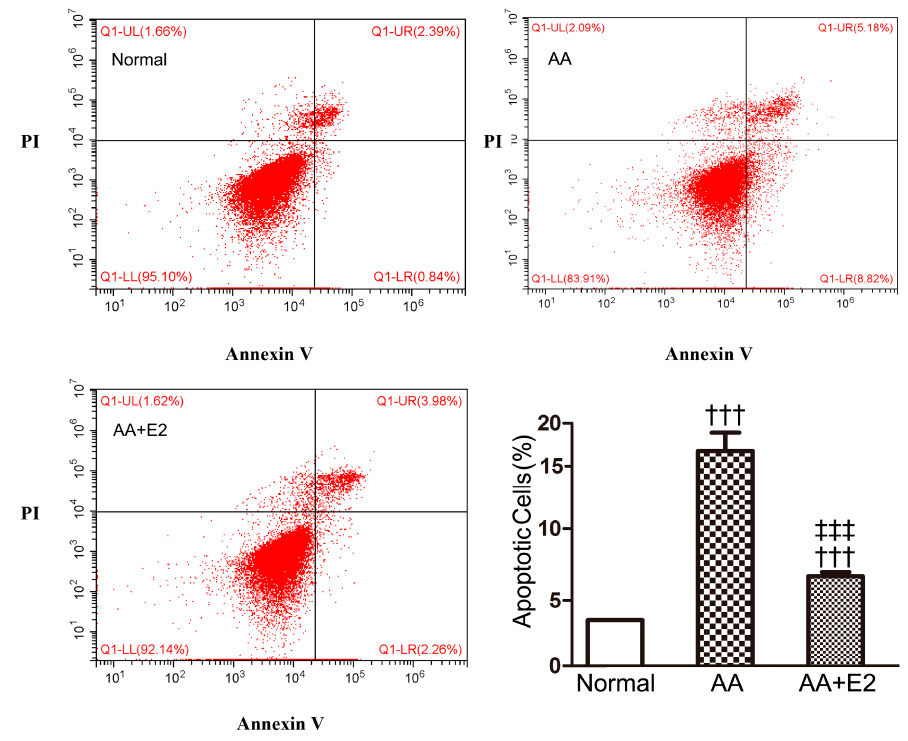
Figure 7. AA-induced HK-2 cells apoptosis, as detected by Annexin V-FITC/PI staining flow cytometry analysis, were blocked by treatment with E2 at 24 h. Annexin V-FITC/PI staining flow cytometry analysis and quantitative analysis of apoptotic cells. The percentage of apoptotic cells was identified by Annexin V + . Data were expressed as means ± SD for three independent experiments. ††† p < 0.001 vs. normal group; ‡‡‡ p < 0.001 vs. AA group.